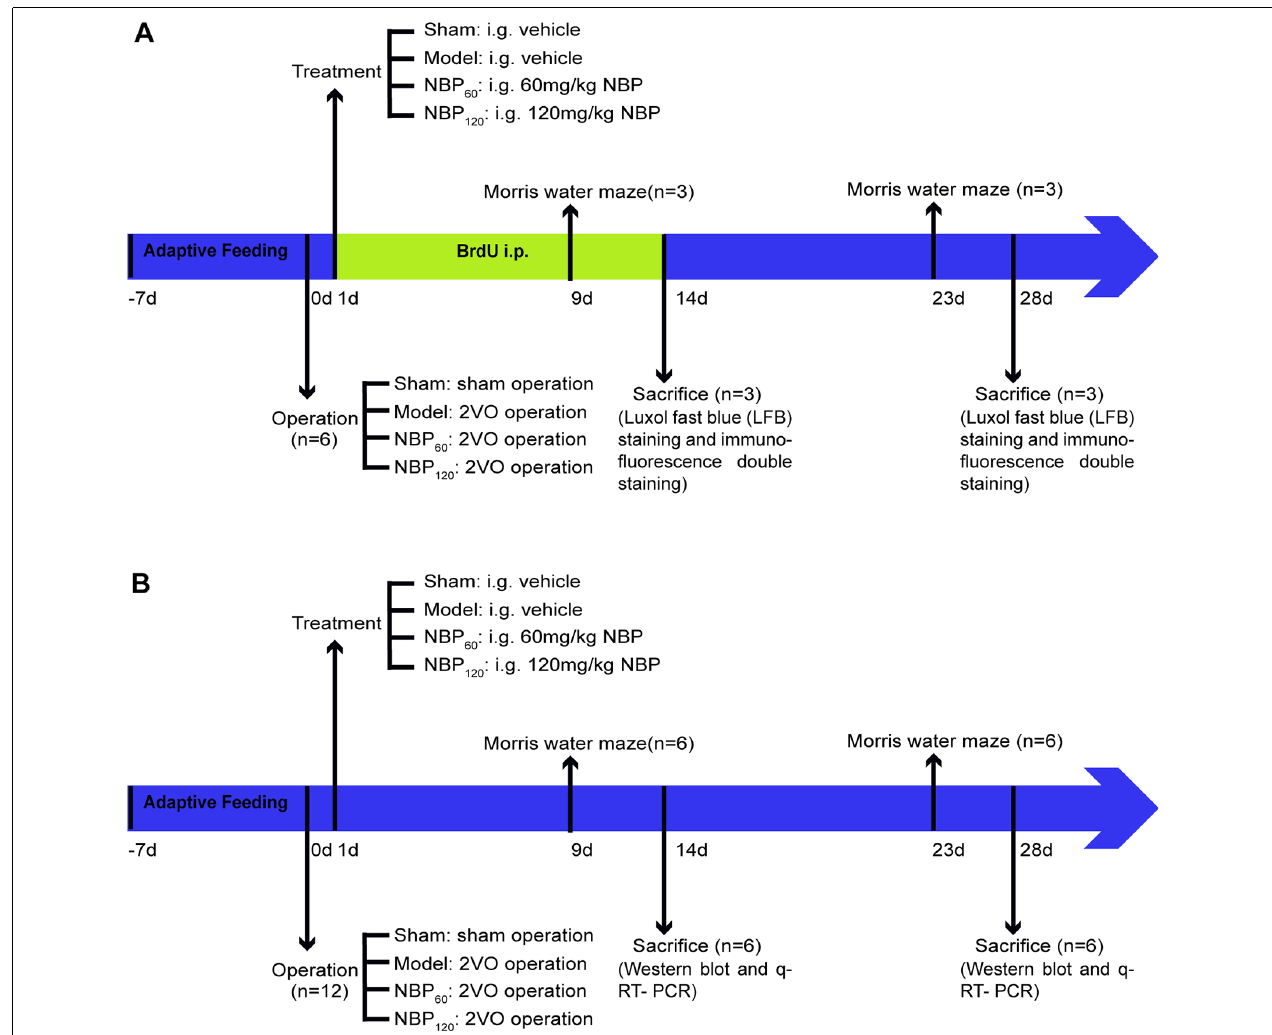
FIGURE 1 | A complete flow chart of this study. (A) The flow chart of the morphological part in this study. The rats in each group were injected with BrdU intraperitoneally for 14 consecutive days. They were sacrificed at 2 weeks and 4 weeks separately for luxol fast blue (LFB) staining and immunofluorescence double staining. n = 6. (B) The flow chart of the molecular part in this study. Rats in each group were sacrificed at 2 weeks and 4 weeks separately for western blot and q-RT-PCR. n = 12.